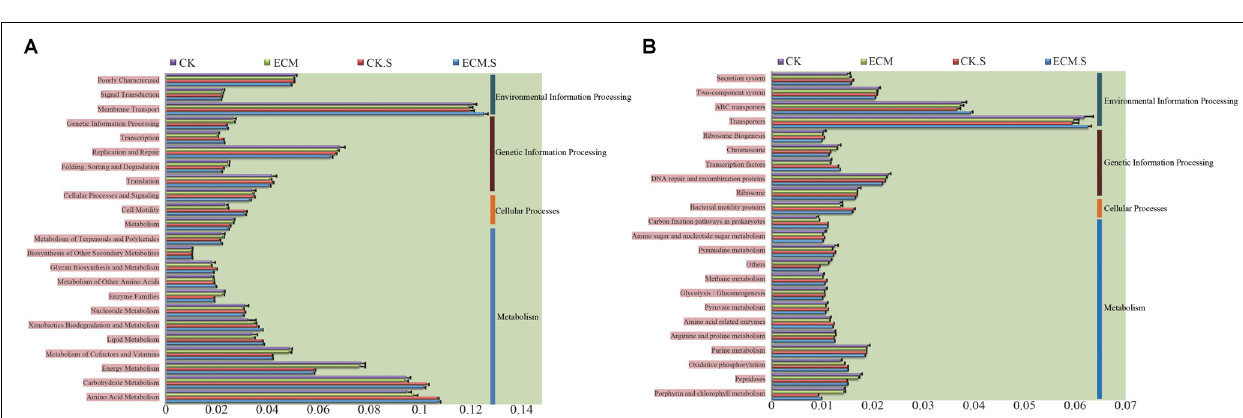
FIGURE 5 | The relative abundance of the putative metabolic functions of the bacterial community in Q. aliena roots and the surrounding soil, predicted using PICRUSt software based on the KEGG database at the second (A) and third (B) classification level. ECM, ectomycorrhizae; ECM.S, ectomycorrhizosphere soil; CK, roots of Q. aliena without T. indicum partner; CK.S, rhizosphere soil of Q. aliena without T. indicum partner. The X axis indicates the relative abundance of the metabolic functions of the prokaryotic community. Data of the above metabolic function analysis are presented as mean ± SD (error bars), calculated from the four biological replicates of each treatment